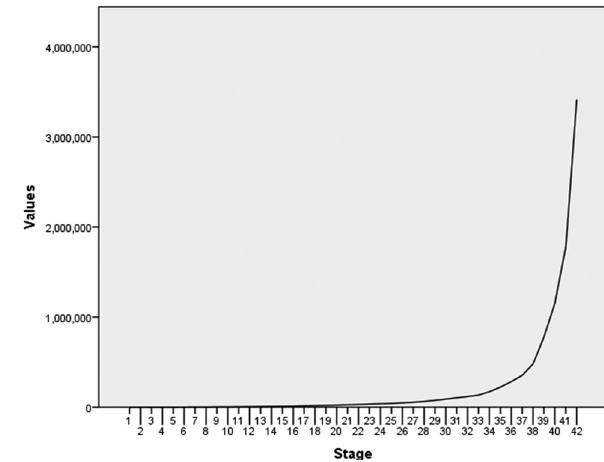
Figure 4: Bi - plot of variables used in PCA analysis. Figure 5: Agglomeration schedule coe ffi